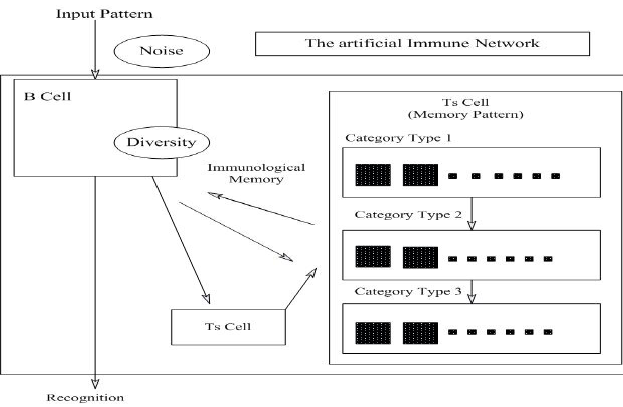
Figure 7. Pattern recognition using artificial immune network